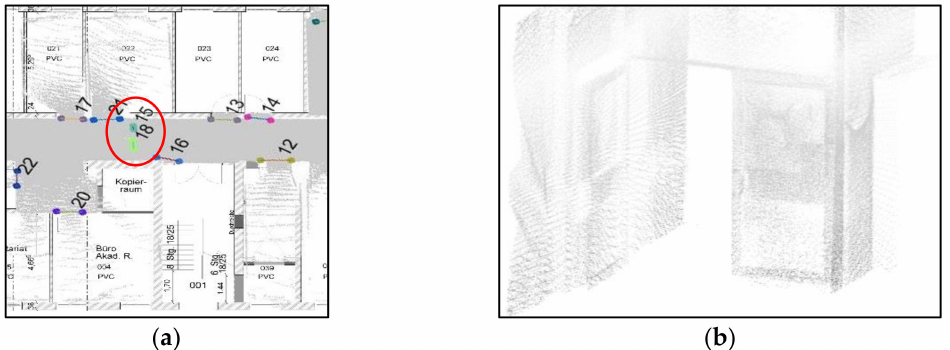
Figure 22. Point cloud of the double-door in the corridor area.